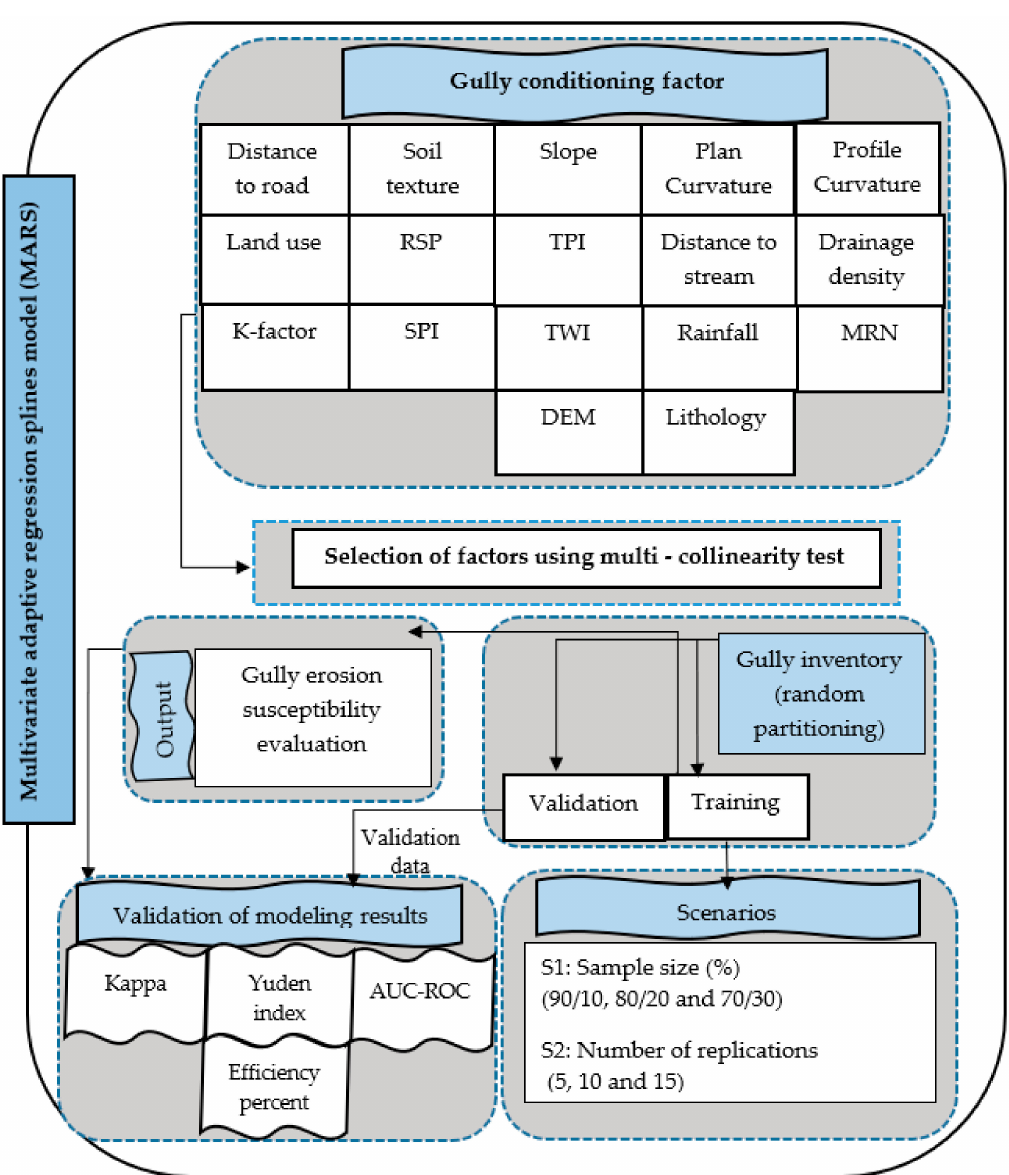
Figure 3. Flow diagram for the research